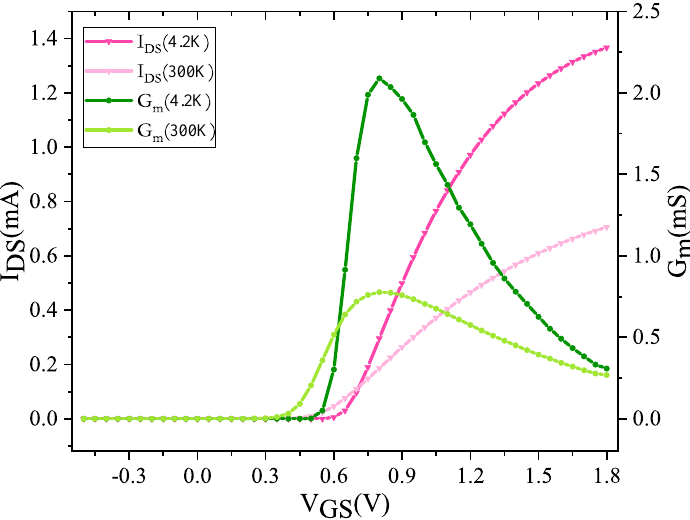
Figure 2. The difference of G m and I DS at RT and